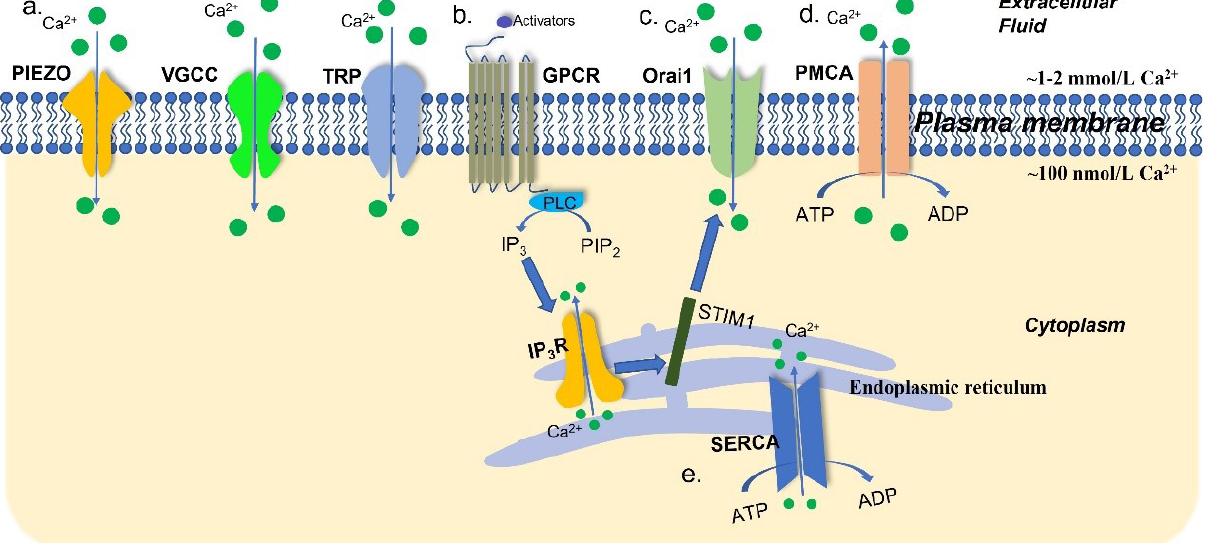
Figure 1. An overview of Ca 2+ channels, transporters, and pumps in the plasma membrane and ER. Intracellular Ca 2+ concentration is governed by a tightly mediated mechanism. (a) The TRP channels, VGCCs, and stretch-activated PIEZO channels are the Ca 2+ channels and transporters in the plasma membrane; (b) after stimulation by activators, G-protein-coupled receptors (GPCRs) facilitate the dephosphorylation of phosphatidylinositol 4,5-bisphosphate (PIP ) into inositol 1,4,5-trisphosphate (IP ) by 2 3 phospholipase C (PLC). In turn, IP Rs initiate Ca 2+ release from the ER; (c) STIM1 senses the depletion of the ER Ca 2+ stores and 3 activates Ca 2+ influx via Orai1 Ca 2+ channels; (d) PMCAs extrude Ca 2+ ions from intracellular space to the extracellular space; (e) SERCAs transport Ca 2+ from the cytoplasm into ER. ADP: adenosine